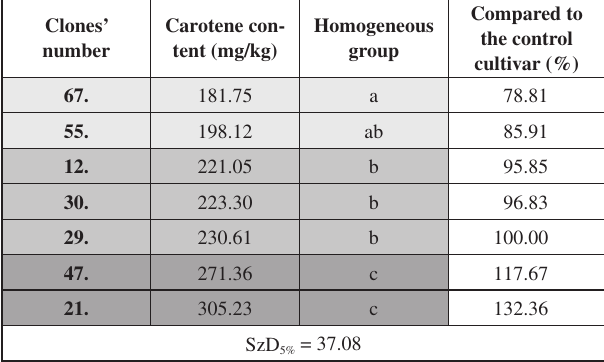
Table 10. The average carotene content (mg/kg) of Lycium berries, in